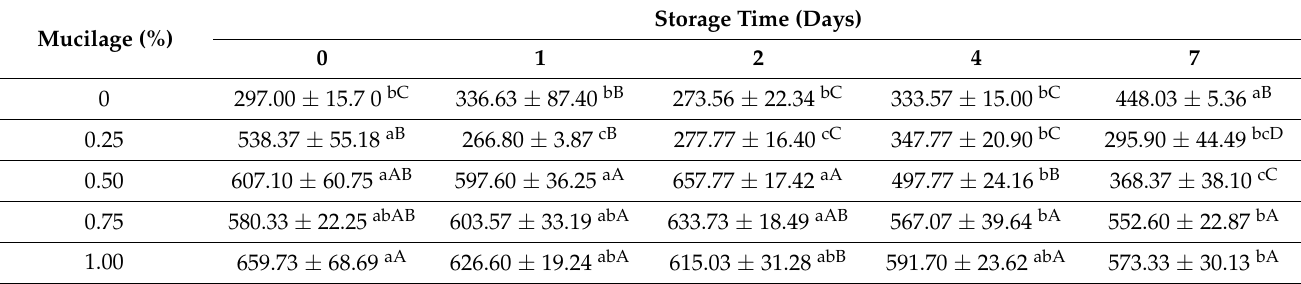
Figure 2. Confirmation of C. olitorius mucilage: ( A ) Molisch’s test, ( B ) iodine test, and ( C ) ruthenium red test. Table 1. Droplet size (nm) of O/W emulsions containing different concentrations of C. olitorius mucilage during seven days of